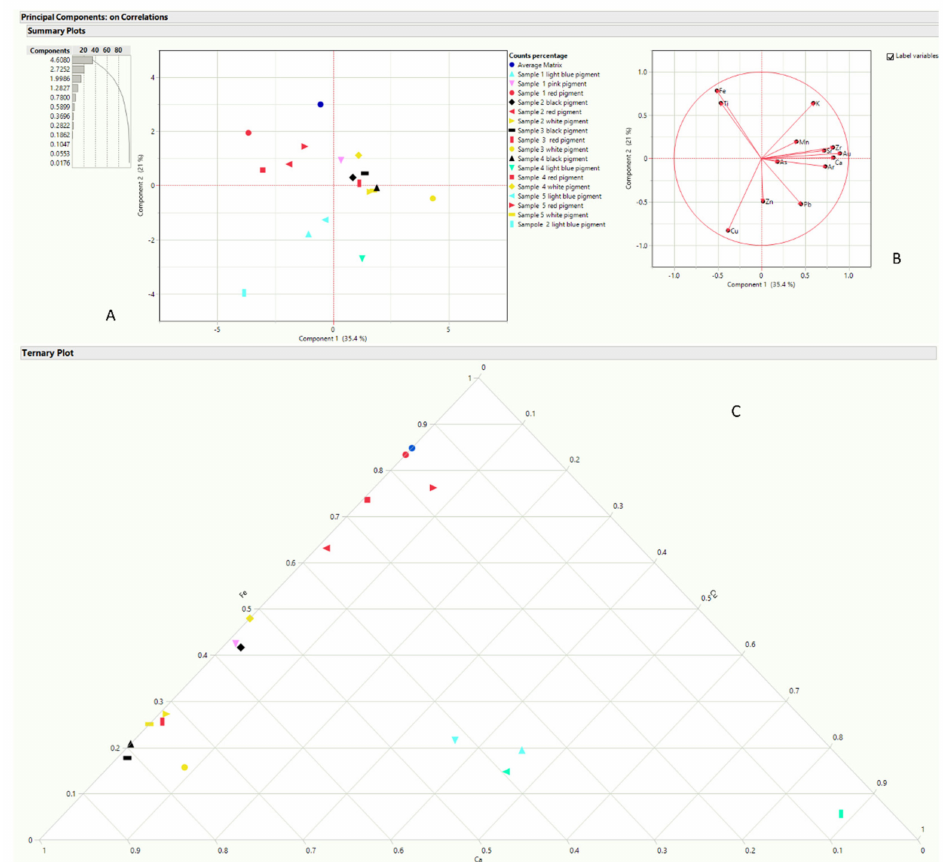
Figure 5. ( A , B ) Principal Component Analysis plot and ( C ) ternary diagram of all pigments analyzed with pXRF.